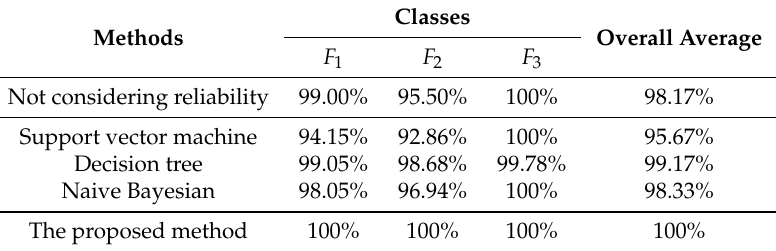
Table 1. The comparing the results of fault